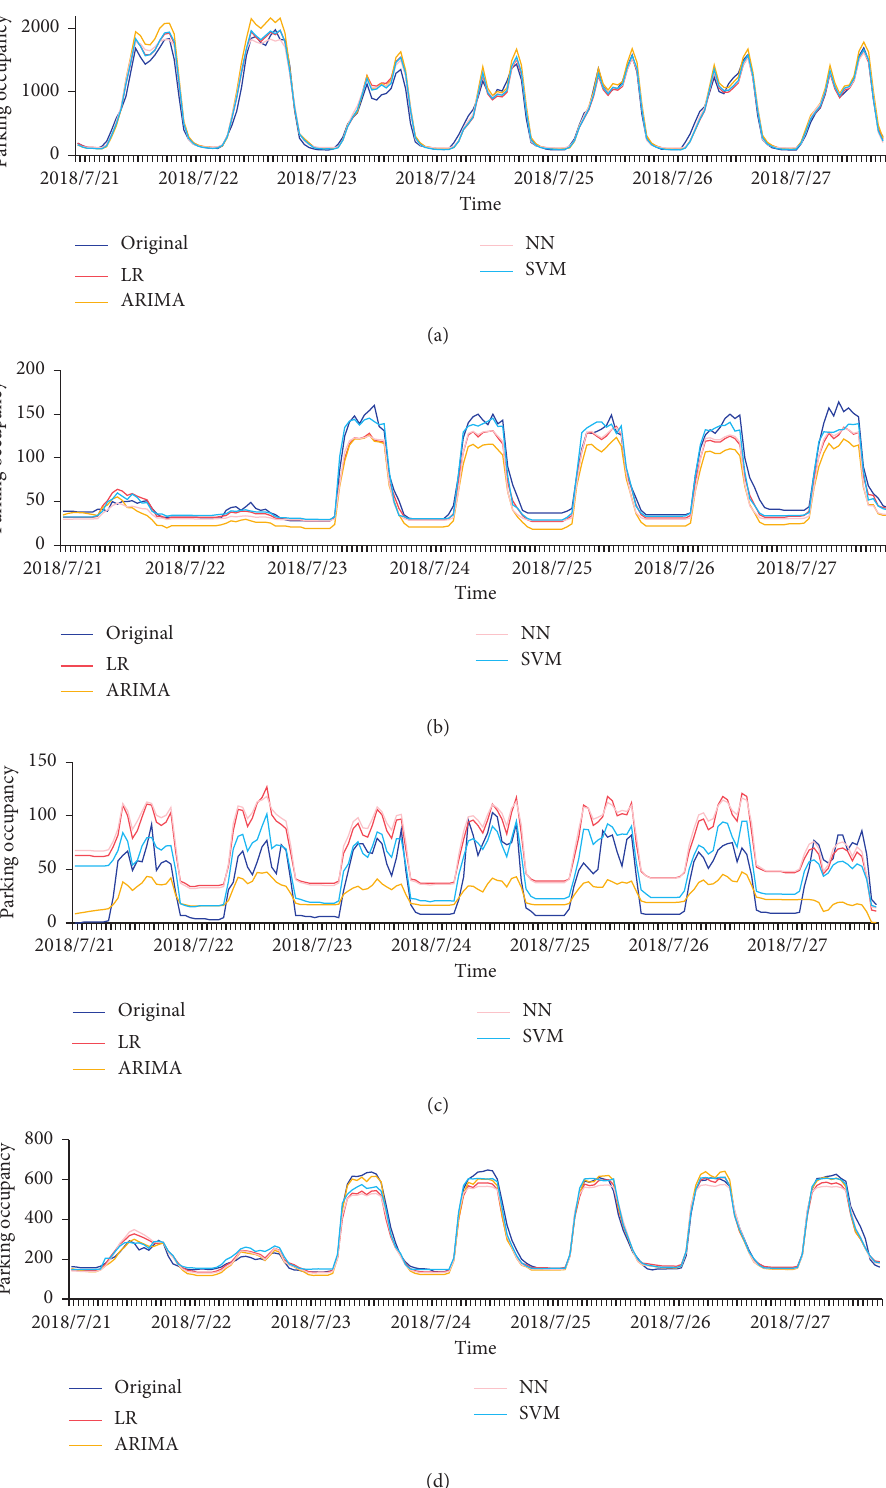
Figure 3: Forecasting results of the four parking lots using FM1. (a) Forecasting result of PL1 using FM1. (b) Forecasting result of PL2 using FM1. (c) Forecasting result of PL3 using FM1. (d) Forecasting result of PL4 using